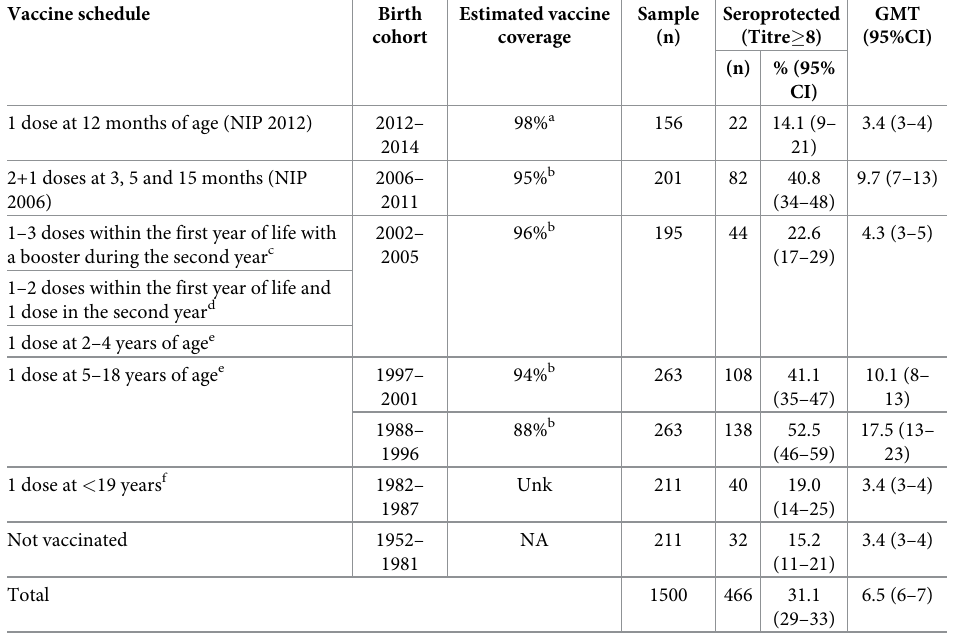
Table 1. Proportion of seroprotected (titre � 8) individuals and geometric mean titre, by vaccine schedule, in Por- tugal, 2015/2016. Vaccine schedule Birth